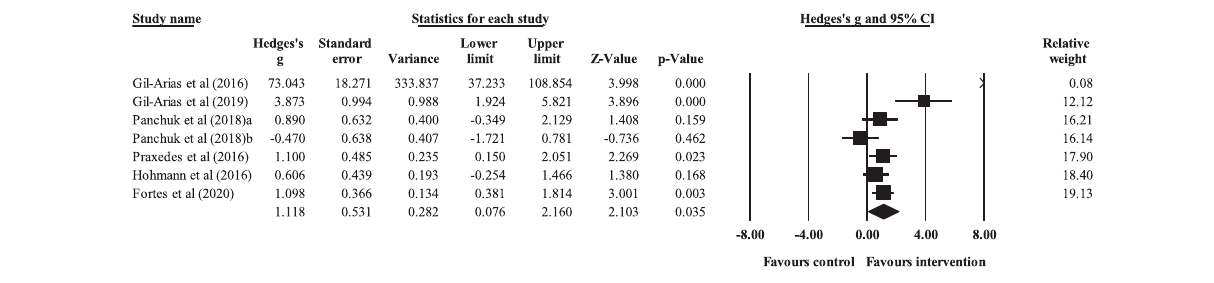
FIGURE 2 | Forest plot of changes in tactical behavior, in youth athletes from team sports participating in decision-making training (intervention) compared to controls. Values shown are effect sizes (Hedges’s g ) with 95% confidence intervals (CI). The size of the plotted squares reflects the statistical (relative) weight of the study.